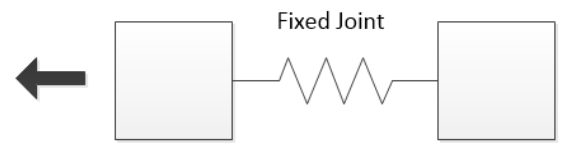
Figure 23. “ Fixed Joint ” component.